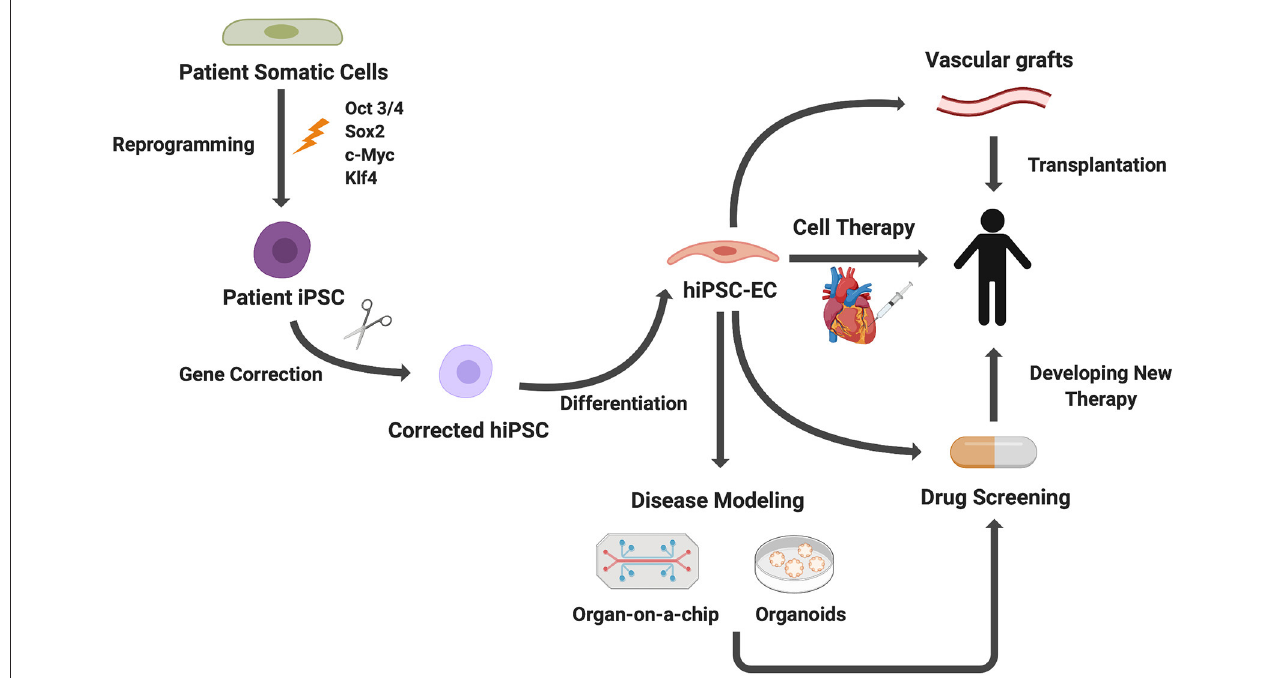
FIGURE 4 | Applications of iPSC-derived ECs. Patient somatic cells are reprogrammed to iPSCs. For genetic diseases, gene editing can be used to correct genetic mutations. ECs differentiated from iPSCs can be used for disease modeling, cell therapies, drug screening, and vascular grafts.